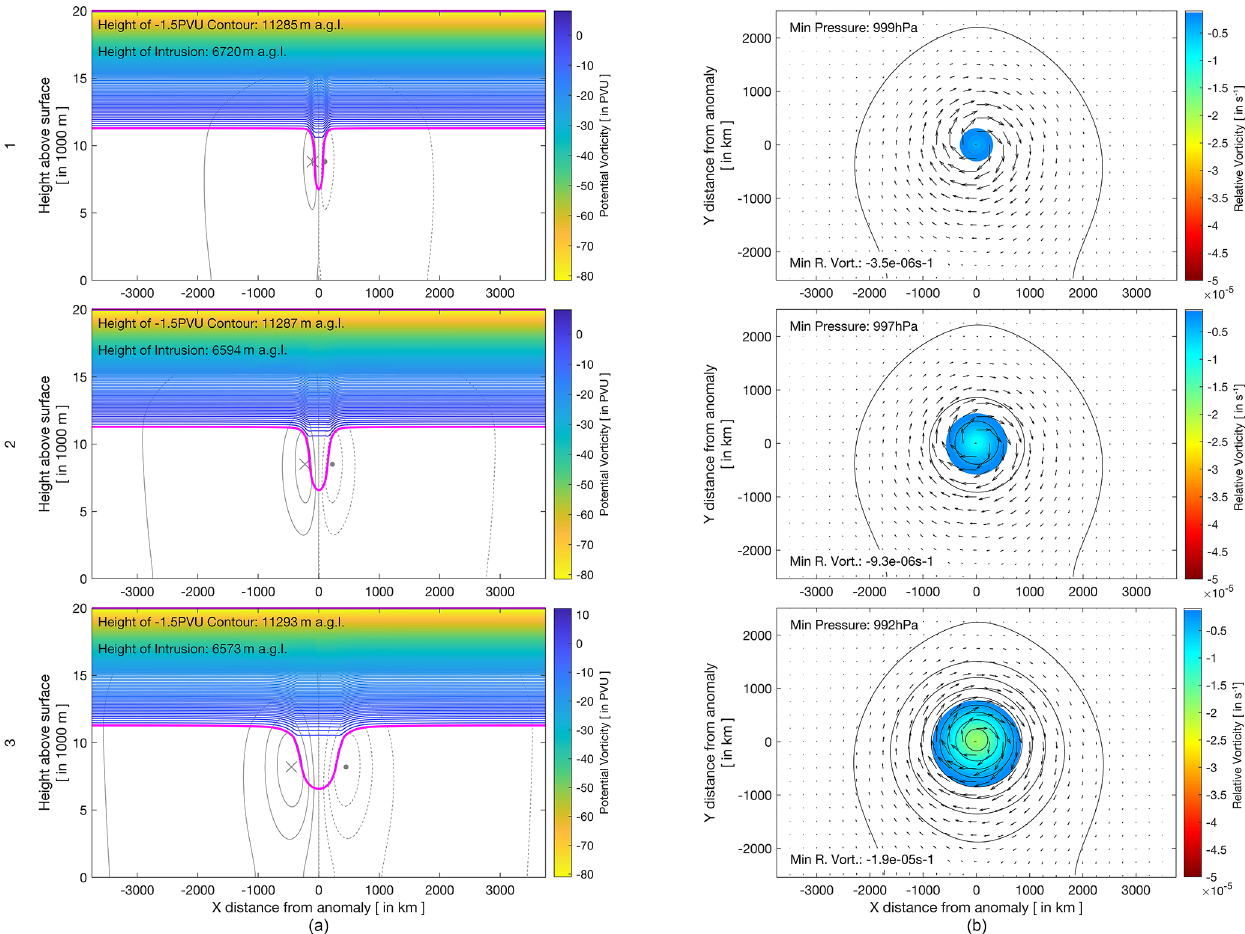
Figure 14. Same as in Fig. 7 but with variable anomaly radial widths such that the heights of the stratospheric intrusions a.g.l. are similar from a constant dynamical tropopause depth of 12500m. The thinner intrusion is created by an anomaly with a 100km radial width (row 1), whilst the broader intrusion is created by a 400km radial width (row 3). Experiment 0 (200km radial width) is provided in row 2 for convenience and comparison.